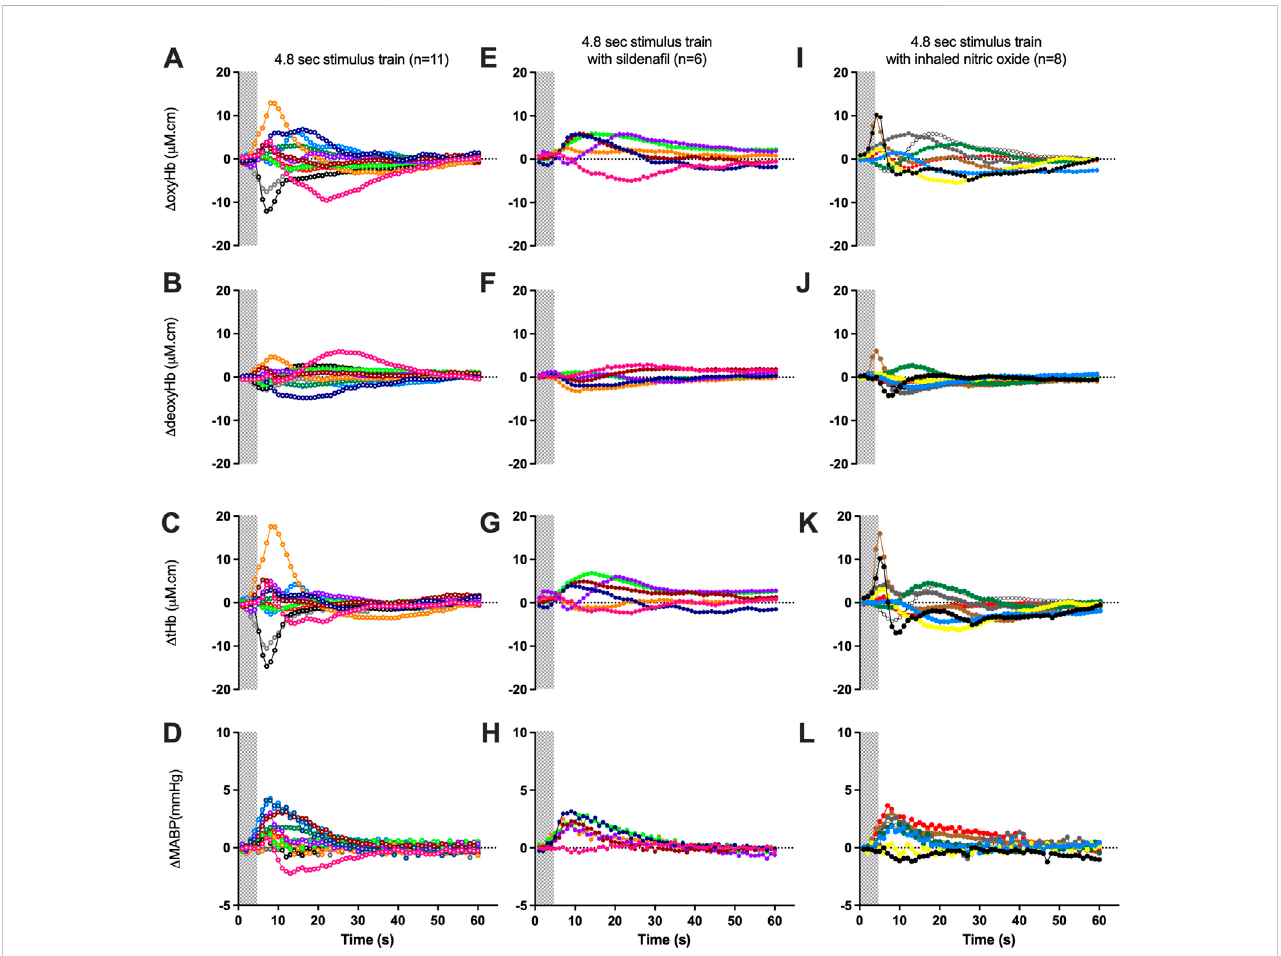
FIGURE 2 Changes in oxy-, deoxy- and total haemoglobin [ Δ oxyHb; (A, E, I) , Δ deoxyHb; (B, F, J) , and Δ total Hb; (C, G, K) ], recorded from the contralateral hemispheres, and mean arterial blood pressure [ Δ MABP; (D, H, L) ], following a 3.3 Hz stimulus train of 4.8 s in control lambs (open circles; A – D), lambs with sildena fi l infusion [solid circles; (E – H) ] or with inhaled nitric oxide [solid circles; (I – L) ]. Individual lambs are indicated by different colours. Shaded area in each graph indicates the period of